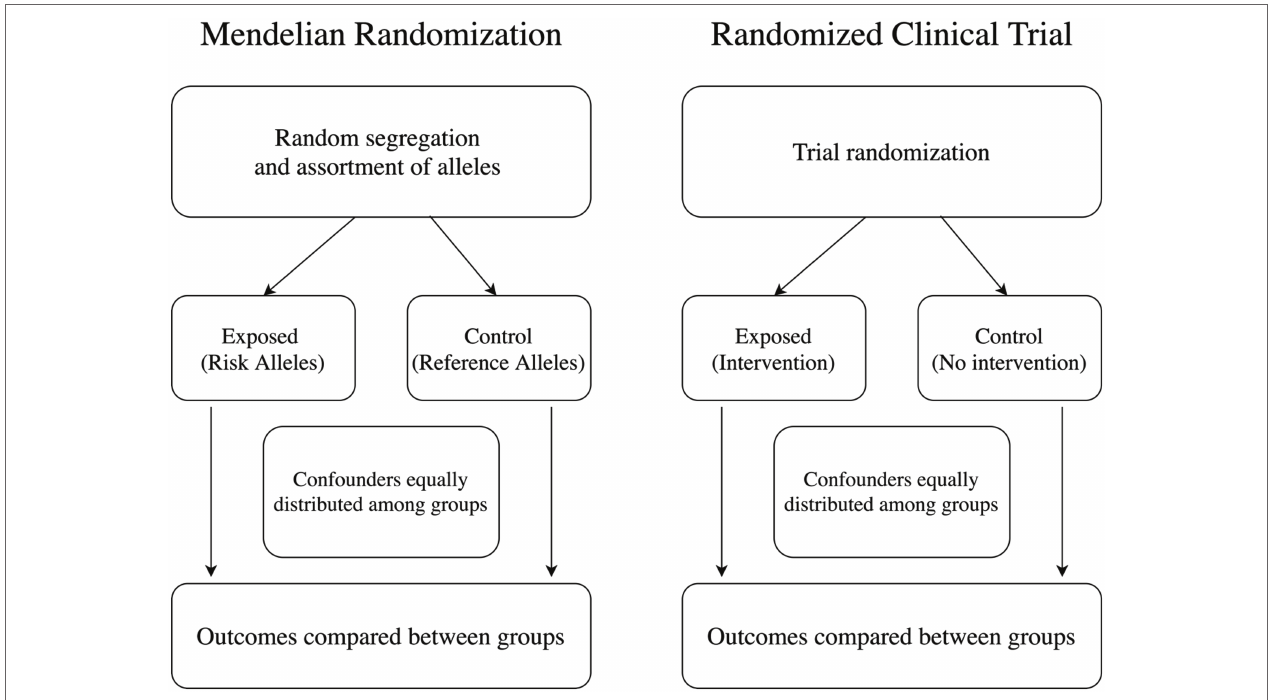
FIGURE 1 | Mendelian randomization (MR) as instrument variable analysis. MR is a type of instrumental variable analysis, similar to randomized clinical trials. Exposed individuals in MR are those carrying risk alleles for determined genetic variants known to associate with an exposure of